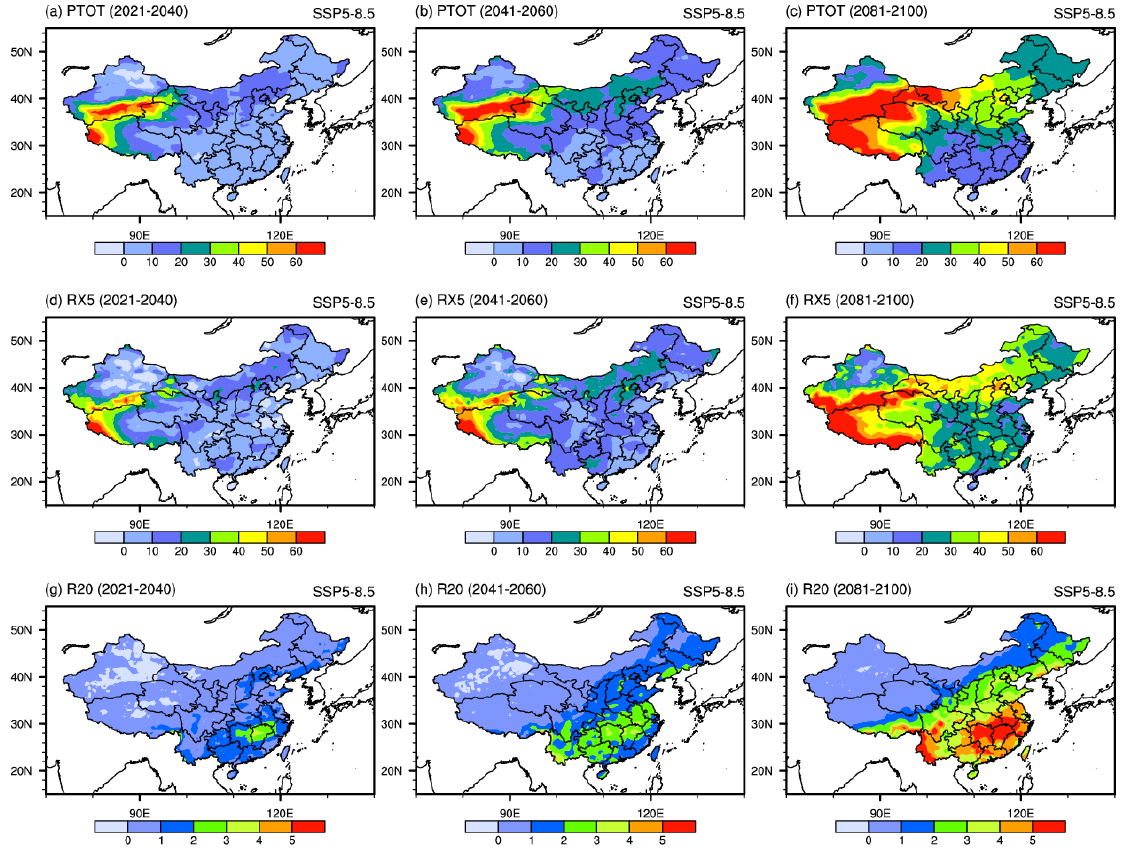
Figure 6. Spatial patterns of extreme precipitation indices (units: %) projected by the downscaled CMIP6 MME under SSP5-8.5 scenario in the 21st century.